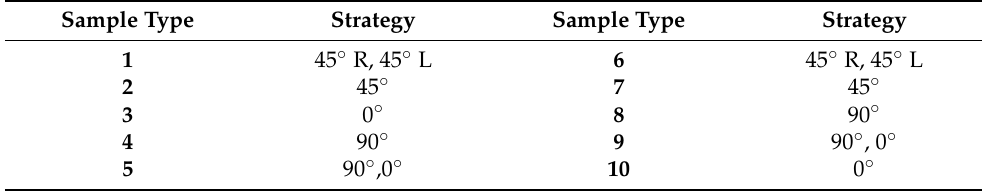
Table 4. Description of the strategies used with respect to the angle of rotation toward the tested sample